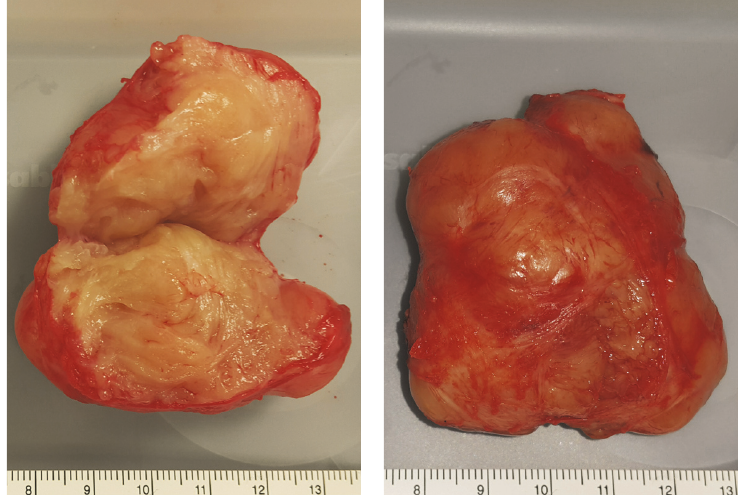
Figure 3: Gross image of excised paraurethral